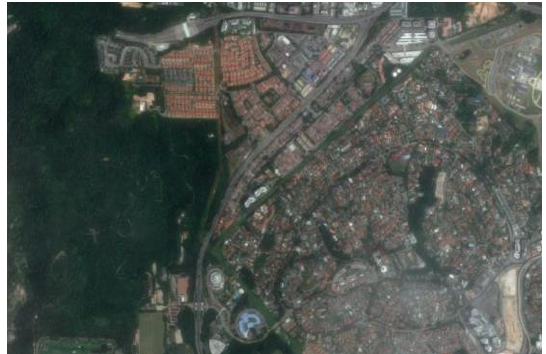
Figure 2. Test Site 1 : Bukit Damansara (Source: Google Map, 2017)